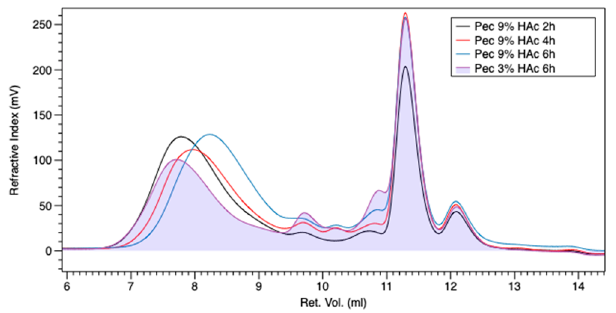
Figure 2. Refractive index detector chromatograms of pectins at 3–9%-HAc and different extrac- tion times: 2 h—black, 4 h—red, 6 h—blue, and 3%-HAc-6 h—violet. times: 2 h—black, 4 h—red, 6 h—blue, and 3%-HAc-6